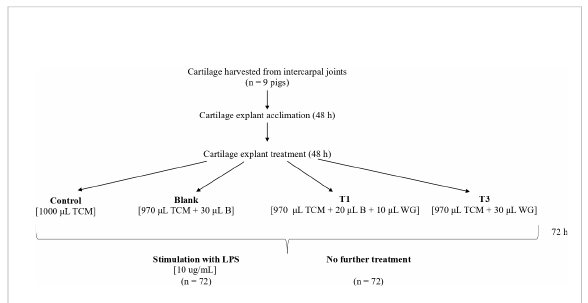
FIGURE 1 Study design for cartilage explants. TSM, tissue culture media; B, Blank (0.28% ethanol in double-distilled water); WG,